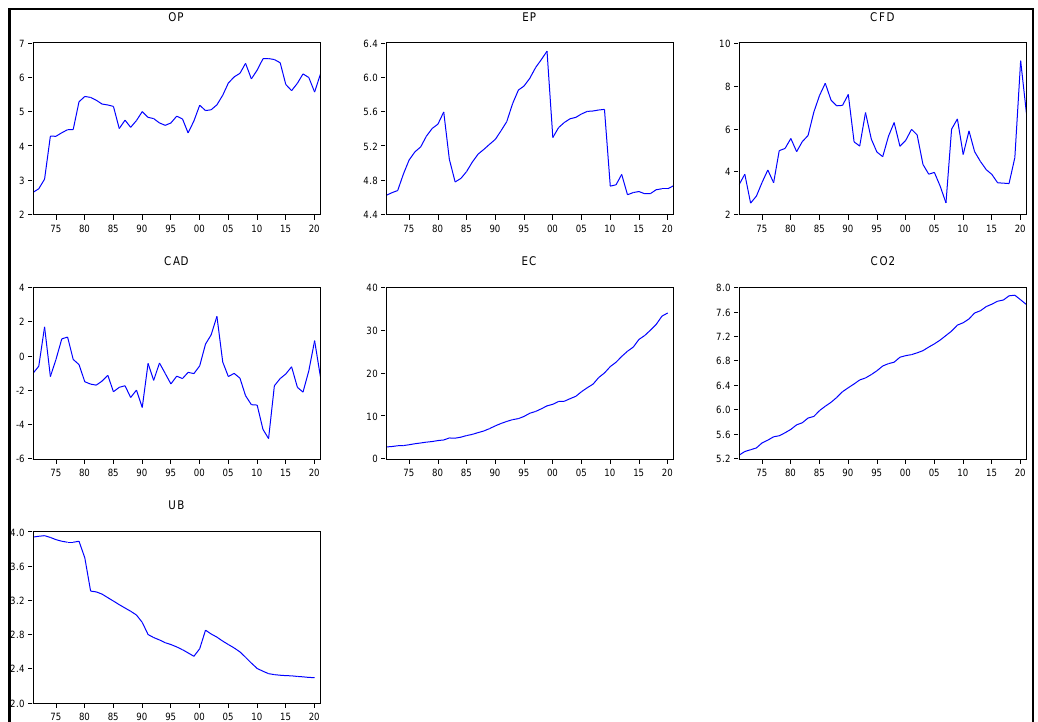
Figure 3. Time Profile of the underlying variables. Source: Authors’ compilation.